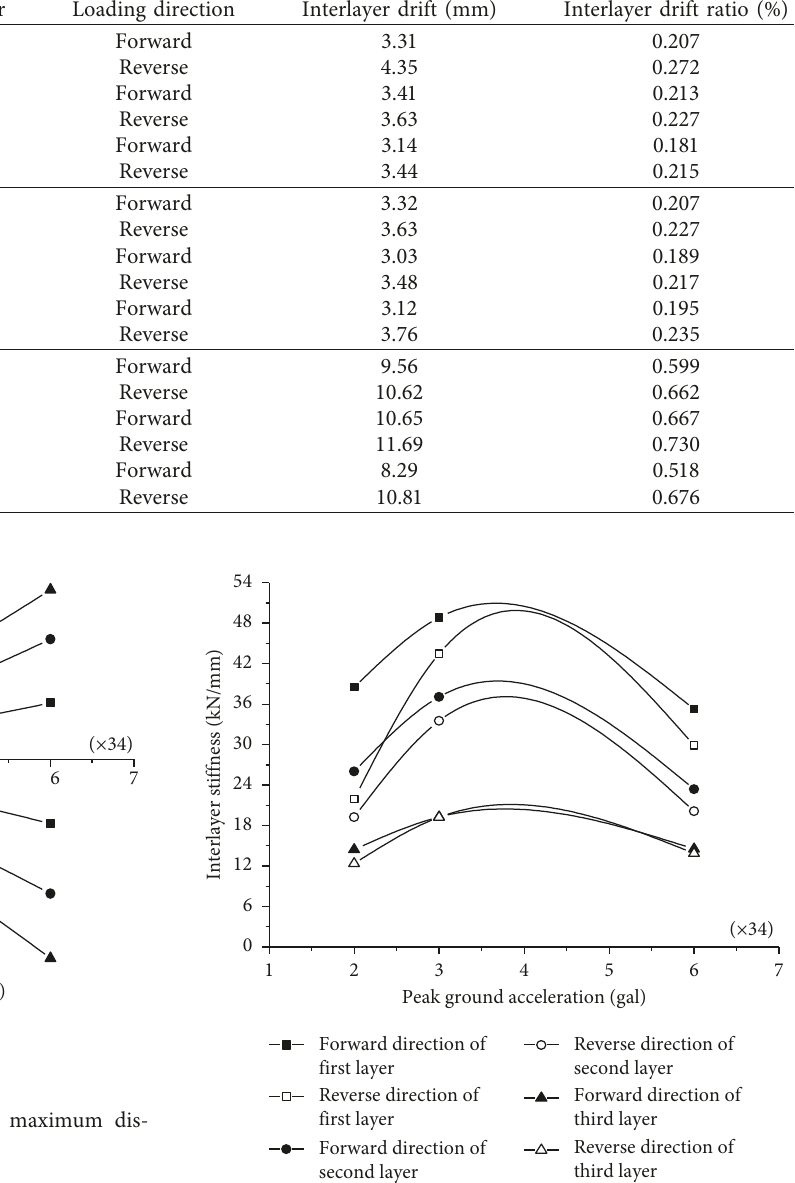
Figure 9: Peak ground acceleration-interlayer stiffness